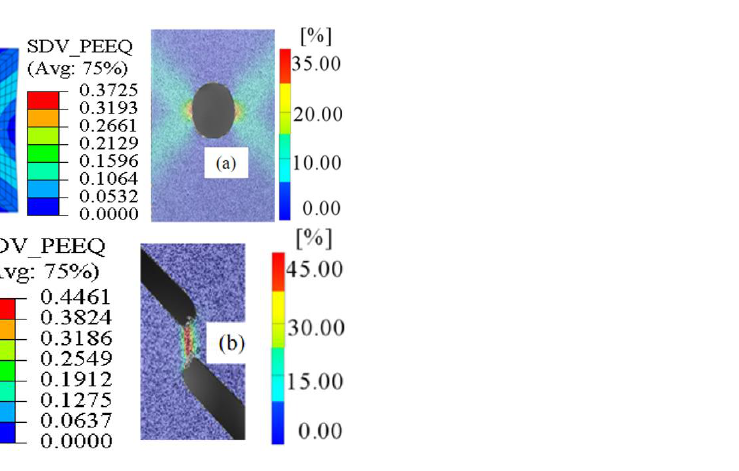
Figure 13. Comparisons of the experimental and simulated equivalent plastic strain to fracture: ( a ) specimen with a central hole; ( b ) notched specimen; ( c ) in-plane shear specimen.